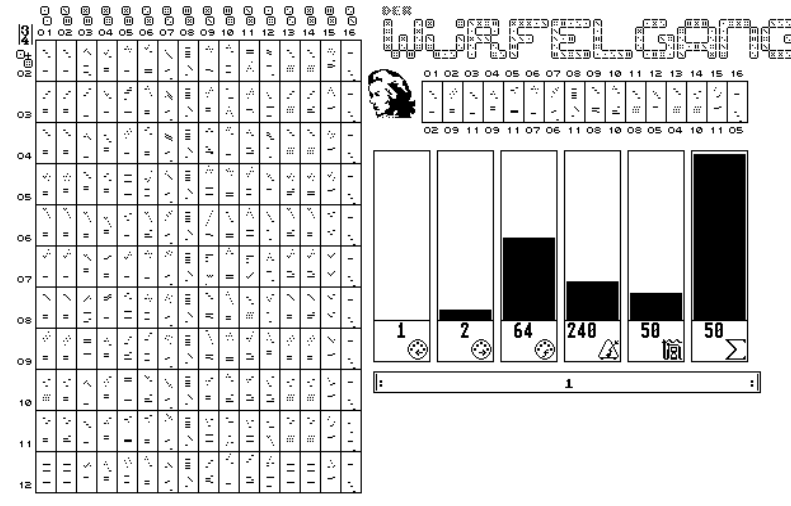
Figure 23: A screenshot of Würfelgang – Mozart’s material at left, parameters and a dice choice at right